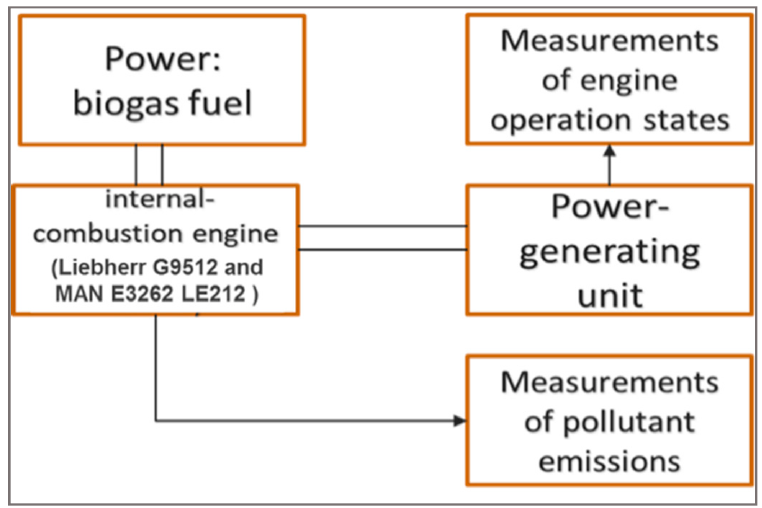
Figure 4. Scheme of the test bench with the two tested CHP internal combustion engines.